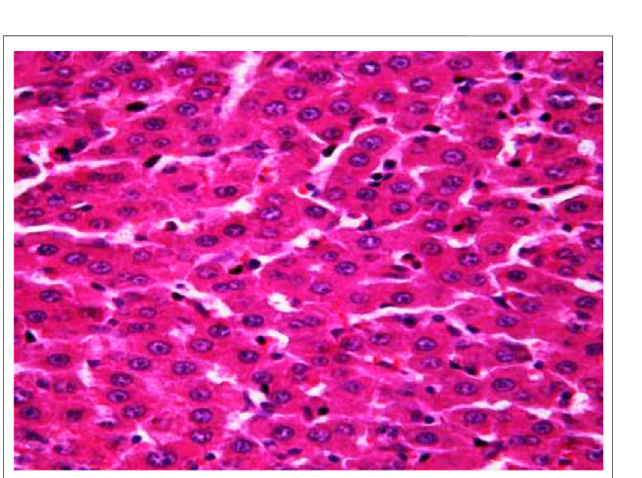
FIGURE 5 | Liver tissue. Positive control group. Hydropic and vacuolar dystrophy of hepatocytes, mainly of the periportal zones of the hepatic lobule. Cytoplasmicvacuolization,pycnoticnuclei,focalnecrosisofhepatocytes;thenuclei arelysed —“ emptycells ” .Stain:hemotoxinandeosin.Magni fi cation ×